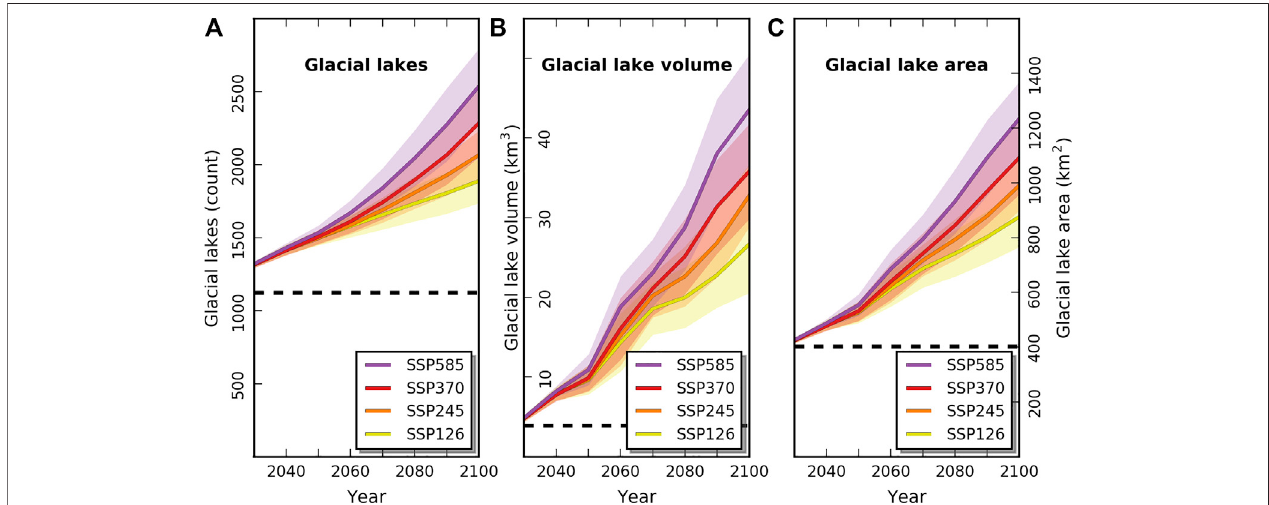
FIGURE 2 | Overview of the development of (A) the number of glacial lakes ( > 0.1 km 2 ) in HMA, (B) their volume, and (C) their area under four SSP scenarios until 2100. Main colored lines represent the mean of an ensemble run of 15 CMIP6 GCMs, while the shaded areas indicate the increasing ensemble standard deviation over time.Thedashed blacklinesindicatethestateofglaciallakes( > 0.1 km 2 )in2018,usingestimatesbyShugaretal.(2020):1,123glaciallakeswith3.9 km 3 ofvolumeand 402 km 2 of area.